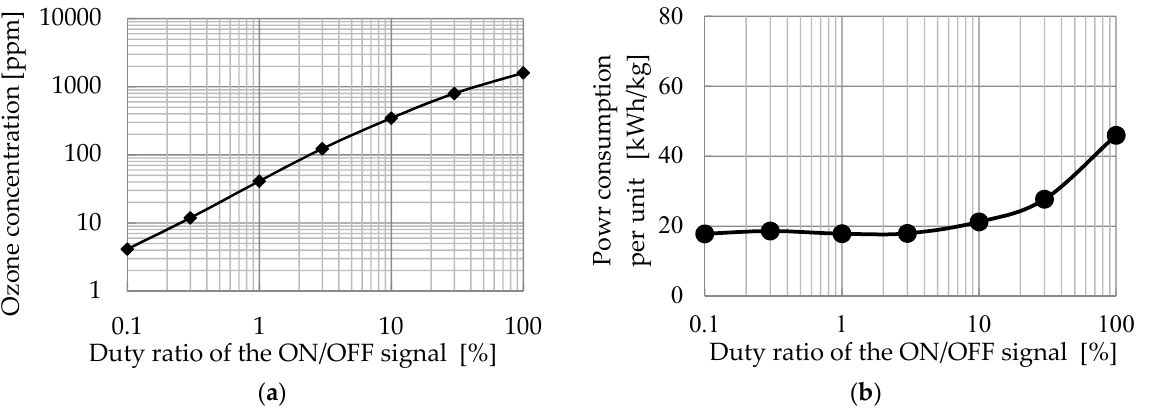
Figure 8. The dependence of the ozone generation characteristics on the duty ratio of the ON/OFF signal: ( a ) ozone concentration; ( b ) power consumption per unit.